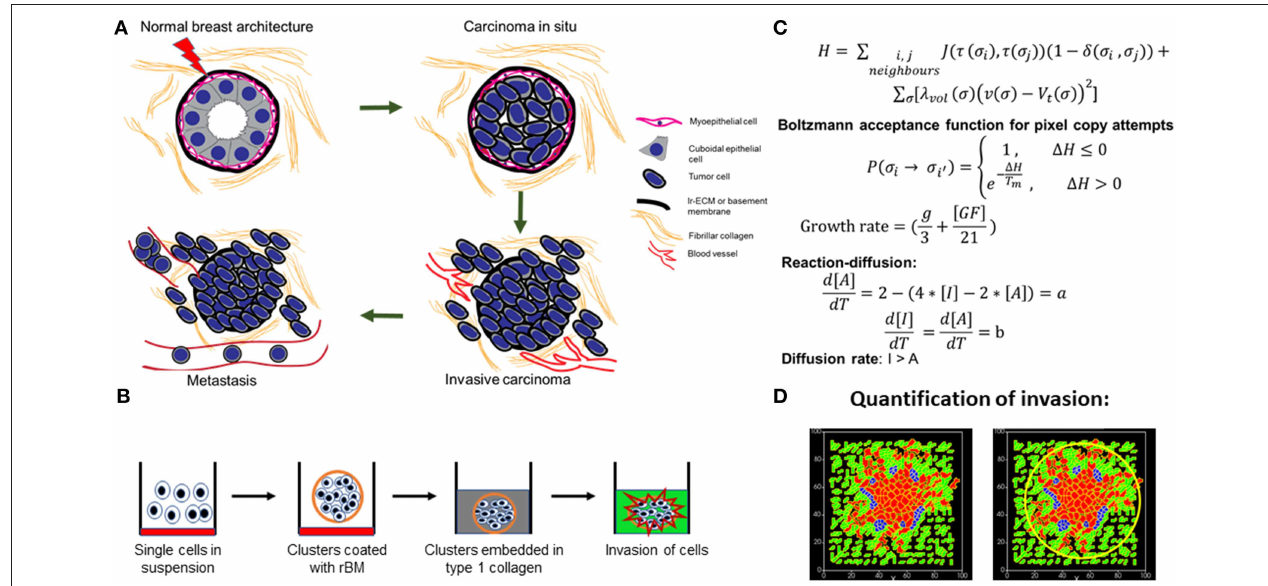
FIGURE 1 | Schematic depiction of experimental system and computational model. (A) Early stages of breast cancer progression: Top left denotes the normal glandular (ductal/luminal) architecture of human breast. Top right denotes the pattern of breast epithelia undergoing ductal carcinoma in situ where normal epithelia are malignantly transformed, lose polarity, and proliferate, resulting in filling up of ductal lumen. Bottom right shows the architecture of invasive ductal/luminal carcinoma where transformed cells breach the basement membrane (BM) and invade into collagen-rich breast stroma. Bottom left shows how invasive breast cancer cells, having traversed through stroma intravasate into blood/lymph vessels and metastasize to secondary organs. (B) Schematic workflow of 3D invasion assay used throughout the paper: Cells are first cultured on top of nonadhesive substrata in medium containing 4% reconstituted BM (rBM). Once cells assembled into clusters, the latter is embedded within type 1 collagen scaffolds and cultured in serum-free conditions. (C) Governing equations used for setting up the computational model. The first equation calculates H , which is Hamiltonian of the simulation: H determines the probability P associated with index-copy attempts, movements by generalized cells to minimize local effective energy through the default dynamical algorithm known as modified Metropolis dynamics. The equation for calculating growth rate shows it to be dependent on [GF], the growth factor concentration, and g , which denotes nutrient availability. Extracellular matrix (ECM) remodeling follows the kinetics of reaction-diffusion (please refer to the appropriate sections in Material and Methods for a more detailed description of model construction). (D) Quantification of invasiveness of cancer cells in the computational model is performed using the minimal enclosing circle algorithm developed using MATLAB.